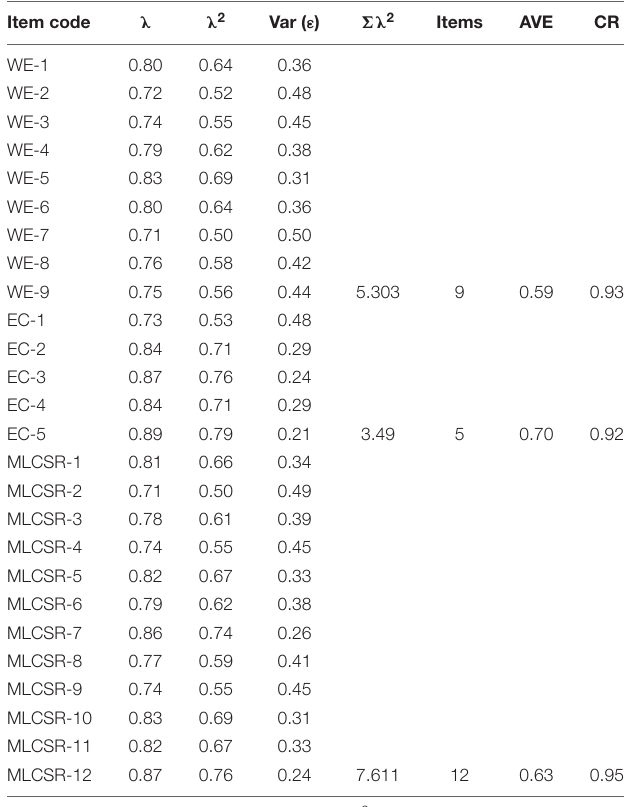
TABLE 2 | Item loadings, convergent validity, and reliability results.